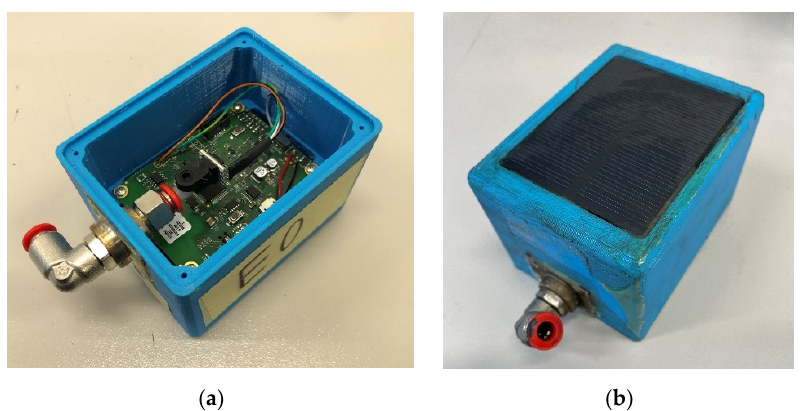
Figure 2. ( a ) Internal view of the sensor node; ( b ) external view of the sensor node showing the PV panel installed on the top of the